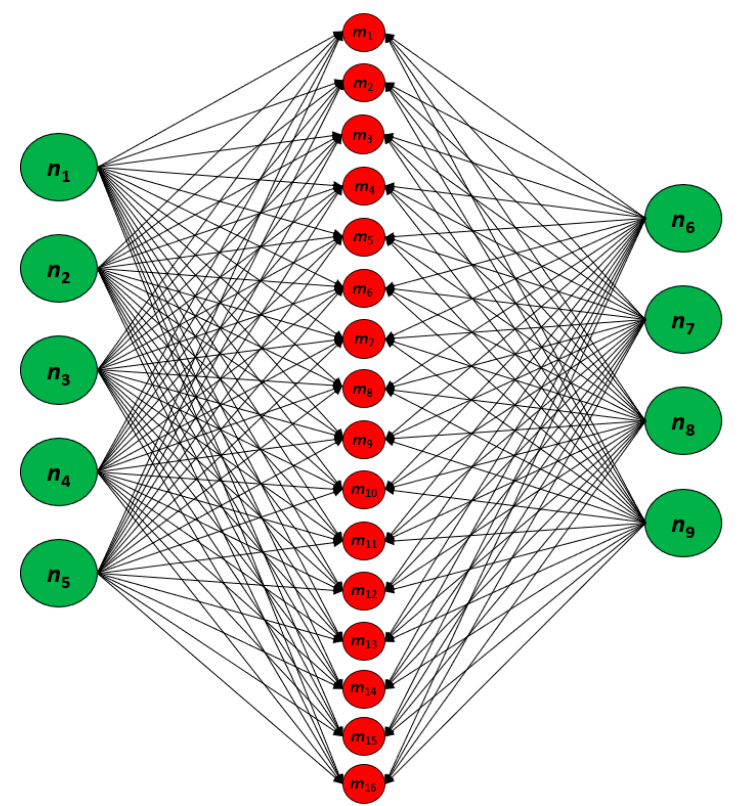
Figure 3. Network structure of the transportation problem.